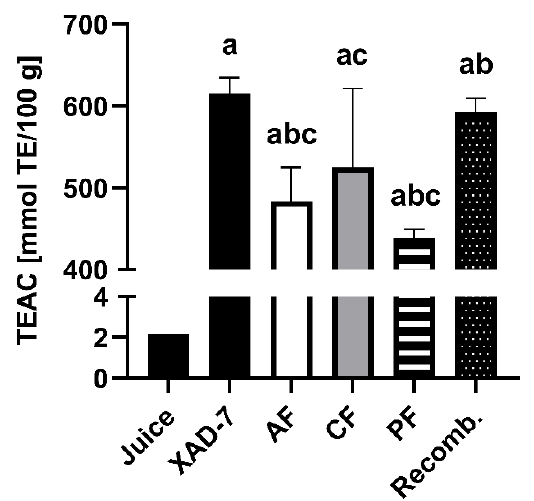
Figure 3. Total antioxidant capacity shown as Trolox equivalent (measured by Trolox equivalent antioxidant capacity (TEAC) assay) of pomegranate juice; XAD-7 extract; its anthocyanin (AF), copigment (CF), and polymeric fractions (PF); and the recombined extract (Recomb.). Results are presented as mean ± SD of three independent experiments. For statistical analysis, one-way ANOVA followed by Tukey’s multiple comparison test was performed. a: significantly different to juice with p < 0.05; b: significantly different to XAD-7 with p < 0.05; c: significantly different to Recomb. with p < 0.05.